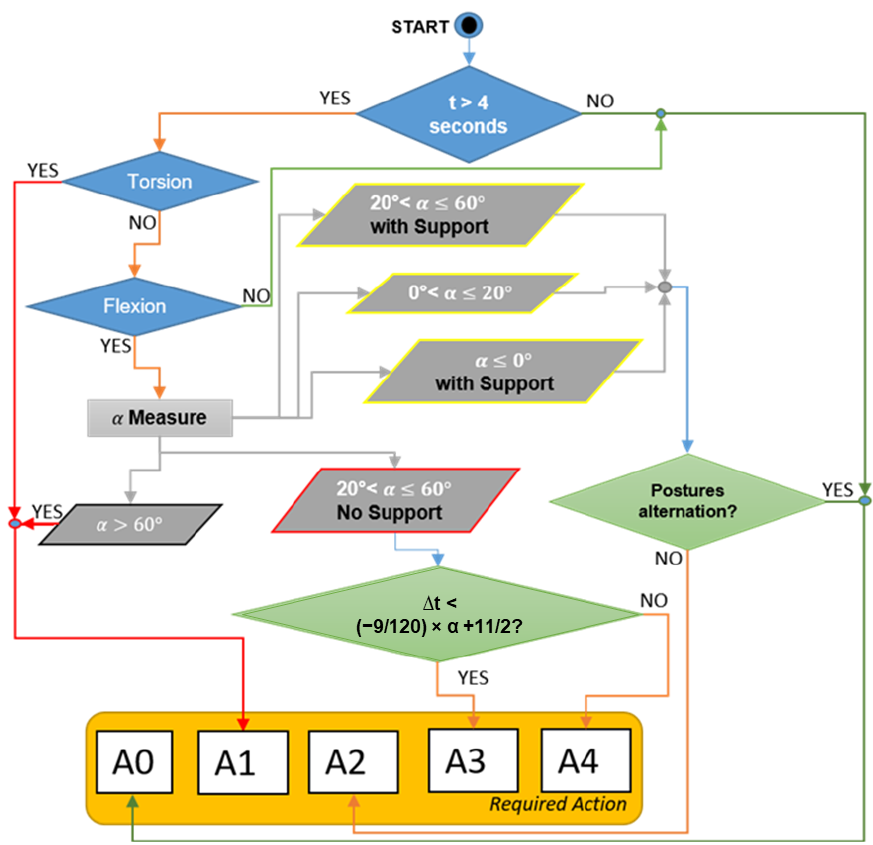
Figure 4. Practical procedure to measure trunk flexion.